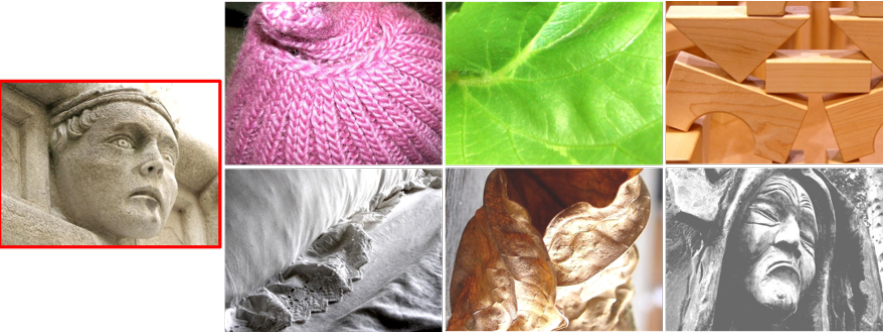
Figure 6. Retrieved results from our proposal using IN ( top ) and BN ( bottom ). From left to right: content image (stone); results of fabric, foliage, and wood